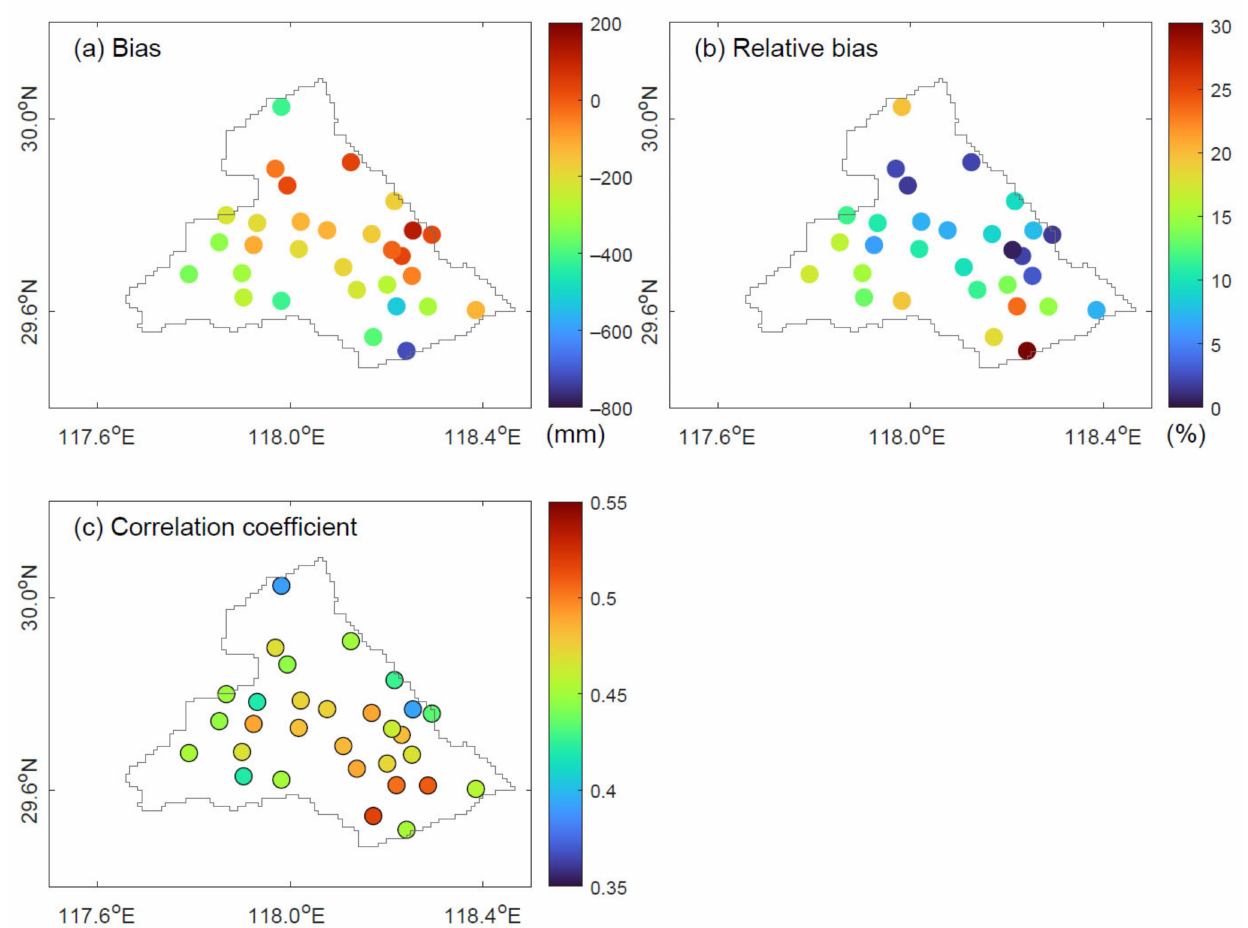
Figure 3. Spatial distribution of ( a ) bias and ( b ) relative bias of annual precipitation and ( c ) correlation coefficient between ground stations and IMERG (point-to-pixel) on 30 min time scale. The point with black circle means it has passed the significant test with the significance level of